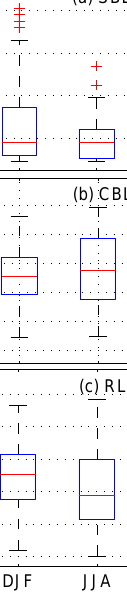
lier, the mean CBL varies between ∼ 0.5 and 3.0 km and the mean SBL varies between ∼ 0.09 and 0.6 km. The mean di- urnal variation of the CBL and the SBL (ABL CS hereafter) shows that the CBL evolved slowly with time, attaining max- imum height at 14:00 IST and either remaining constant or decreasing slowly until 17:00 IST and then collapsing to the SBL. The mean variation of the SBL over time is very